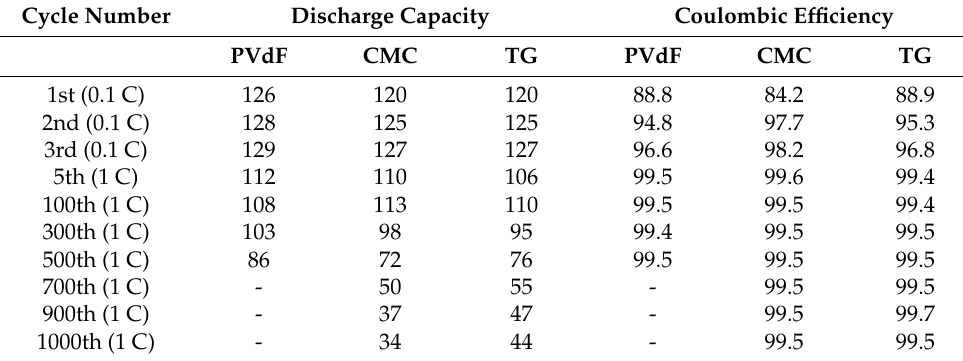
Table 3. Summary of discharge capacity and coulombic-efficiency performance at different cycles related to a long cycling test of LNMO electrodes with different binders. Cycle Number